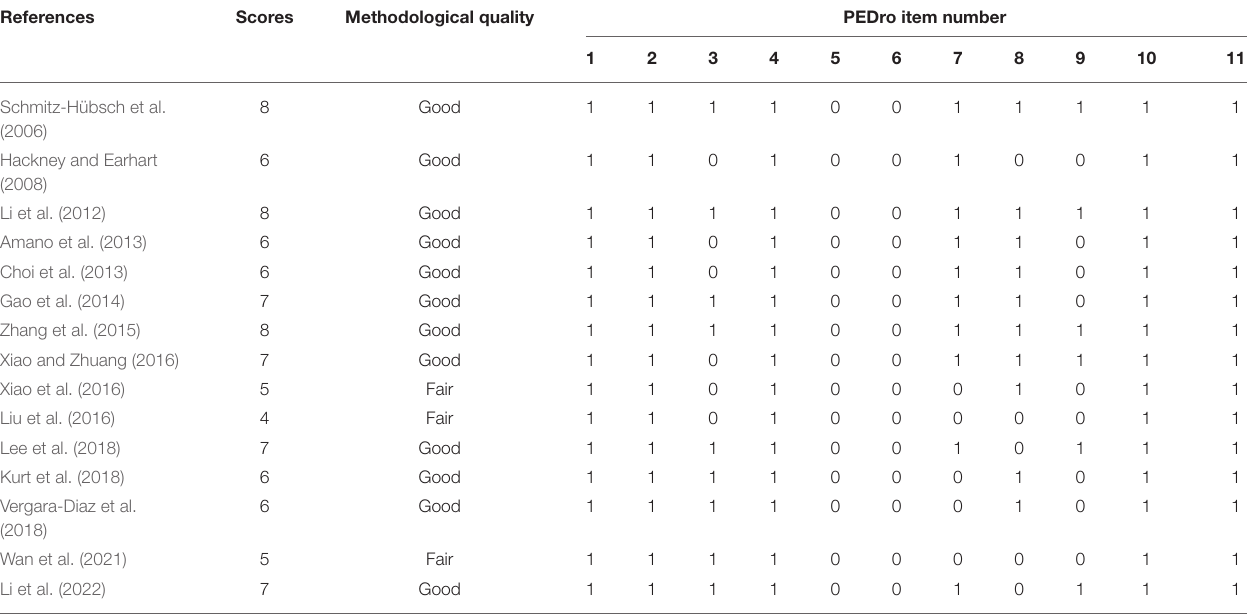
TABLE 2 | Physiotherapy Evidence Database (PEDro) scores of the 15 included